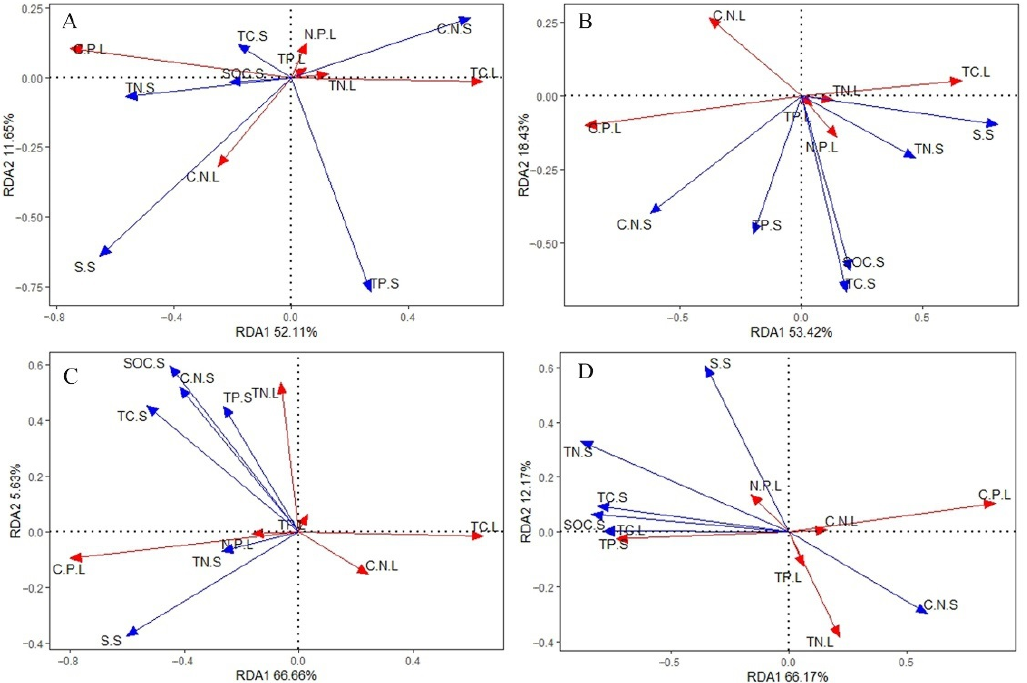
Figure 5. Soil eco-stoichiometry and the relationships between organic carbon ( C ), salinity, and leaf eco-stoichiometry at different tidal levels. Blue and red arrows indicate the soil index and the plant index, respectively. Subfigures ( A – C ) represent the sample lines at the three tidal levels: 1, 3, and 5 km from the coastline (T1, T3, and T5, respectively); ( D ) represents all sample points from three tidal levels. TC.L: soil total C content; TN.L: leaf total nitrogen (N) content; TP.L: leaf total phosphorus (P) content; C/N.L: leaf C/N ratio; C/P.L: leaf C/P ratio; N/P.L: leaf N/P ratio; SOC.S: soil organic C content; TC.S: soil total C content; TN.S: soil total N content; TP.S: total soil P content; S.S: soil salinity; C/N.S: soil C/N ratio; C/P.S: soil C/P ratio; N/P.S: soil N/P ratio.